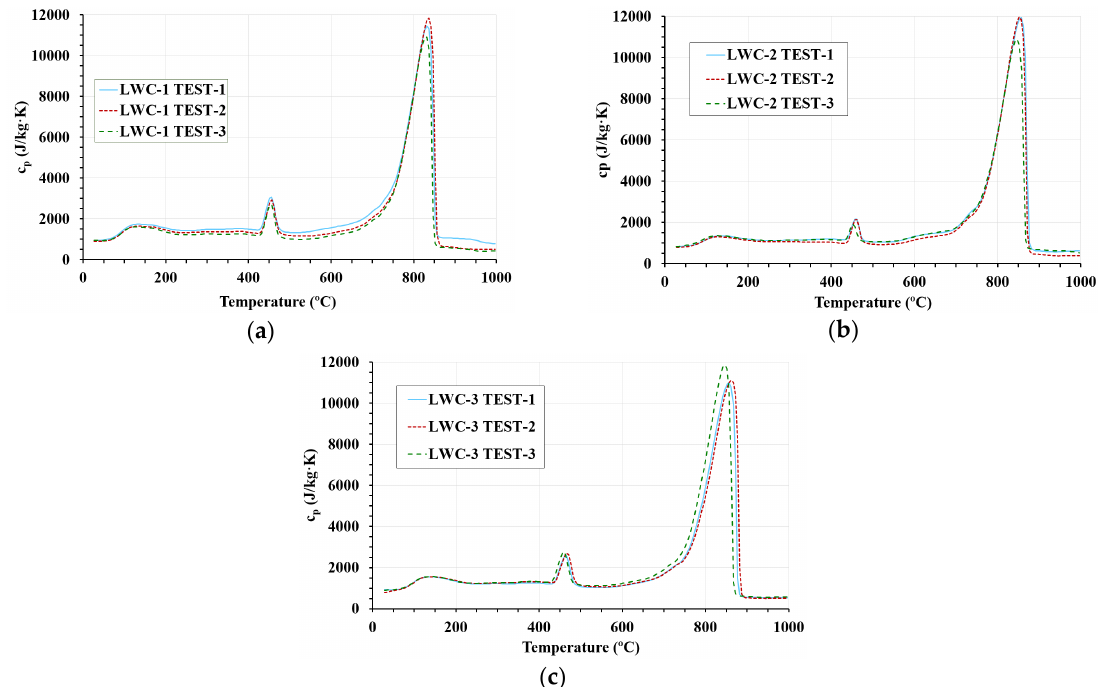
Figure 7. Specific heat for all LWC types: ( a ) LWC-1; ( b ) LWC-2; ( c ) LWC-3.